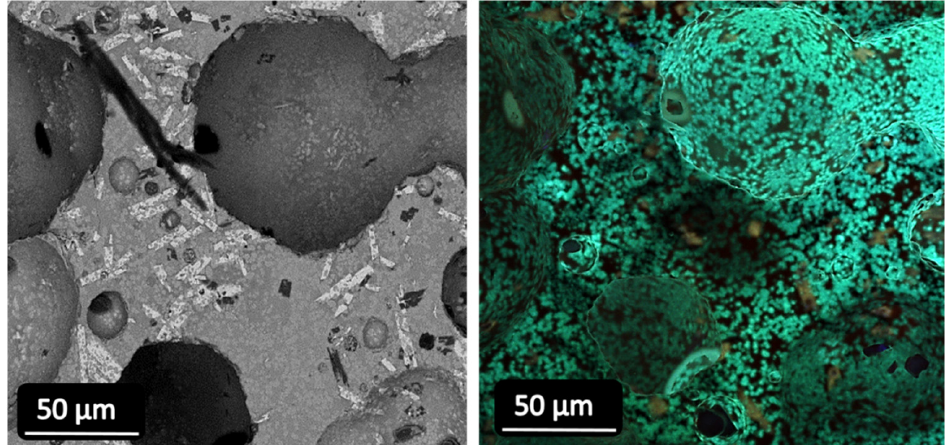
Figure 6. SEM ‐ CL images of the polished surface of GC ‐ 1Eu ‐ 1Dy glass ‐ ceramic. SEM images (×2.0 Figure 6. SEM-CL images of the polished surface of GC-1Eu-1Dy glass-ceramic. SEM images ( × 2.0 k), k), CL images (×1.0 k). CL images ( × 1.0